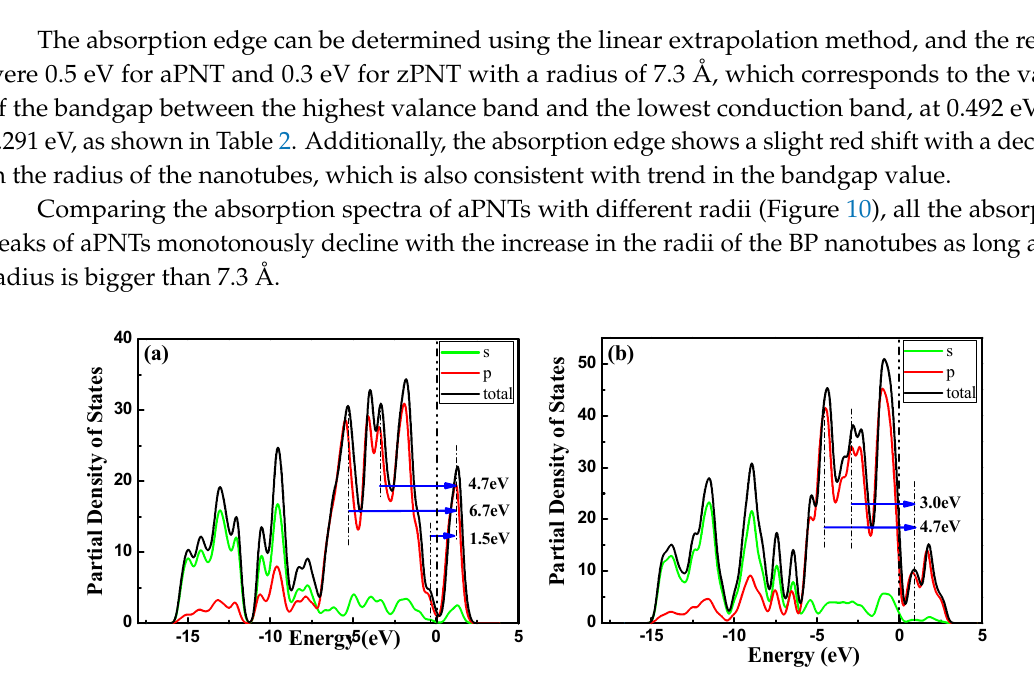
Figure 11. Partial Density of States (PDOS) of BP nanotubes with radius of 7.3 Å: ( a ) aPNTs and ( b ) zPNTs.